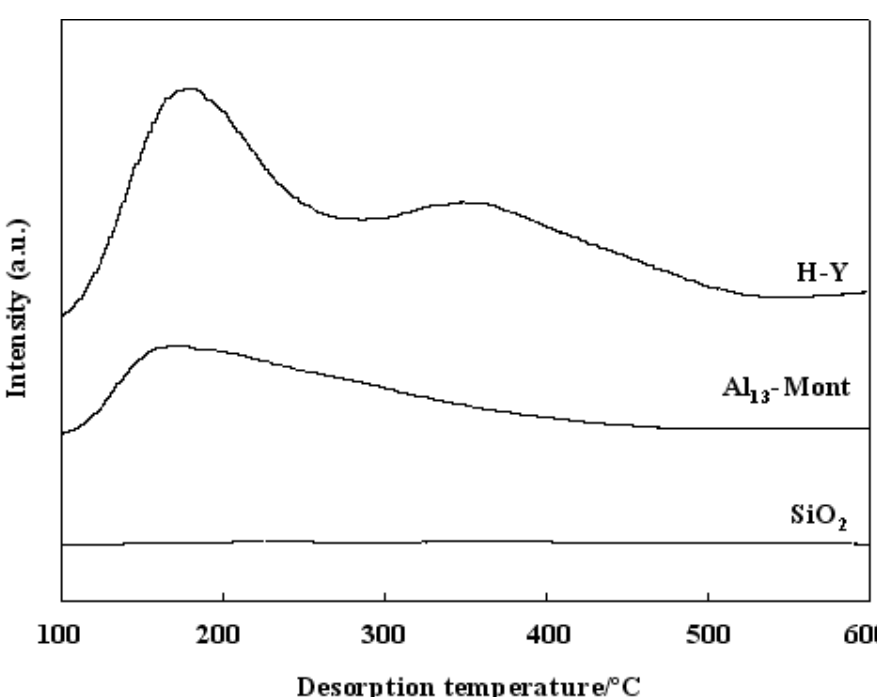
Figure 3. NH -TPD profiles of various solid 3